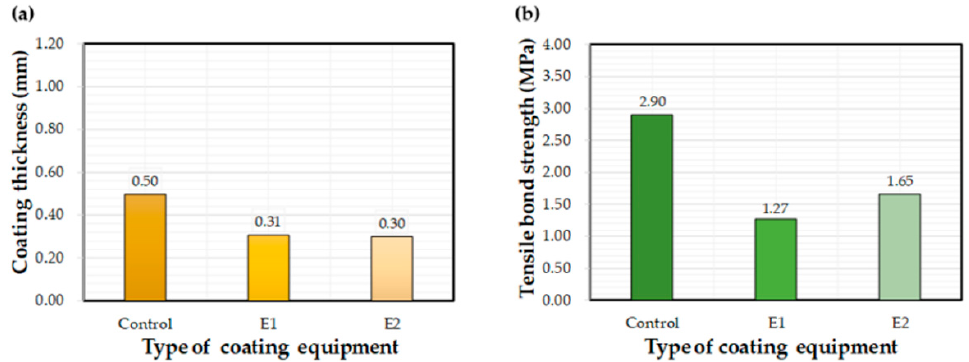
Figure 8. Effects of the selected coating equipment on ( a ) coating thickness and ( b ) bond strength.